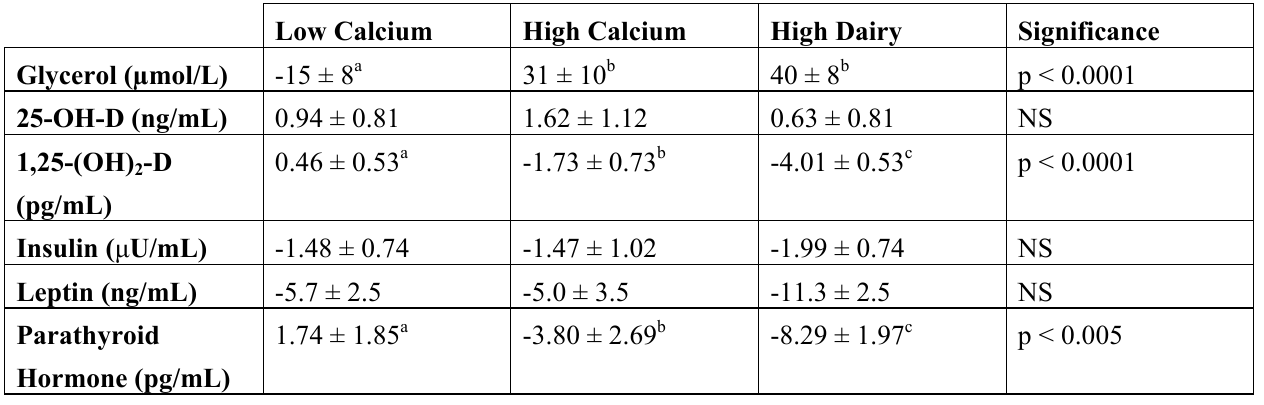
Table 6. Change in Plasma Glycerol and Hormones in Response to Dietary Treatments 1,2,3